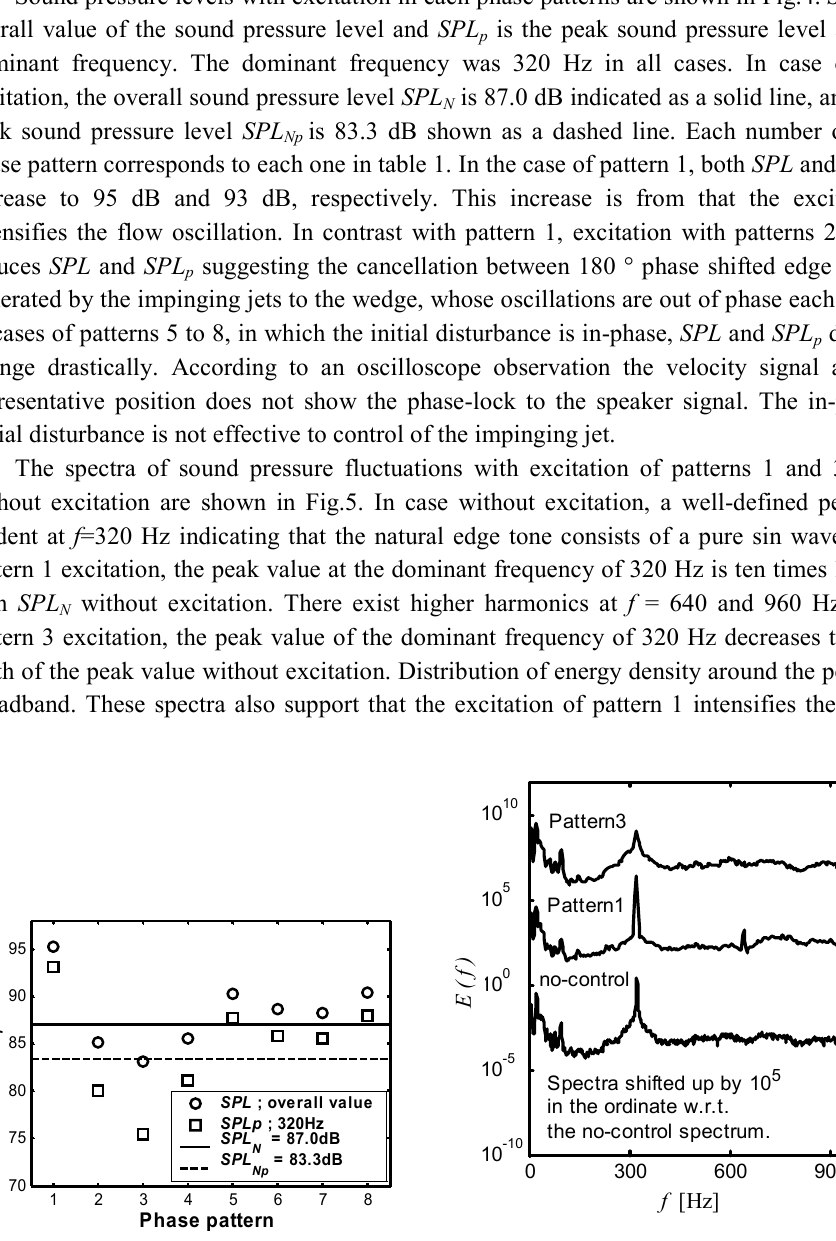
Fig.4 Effect of sound control Fig.5 Spectra of the sound pressure